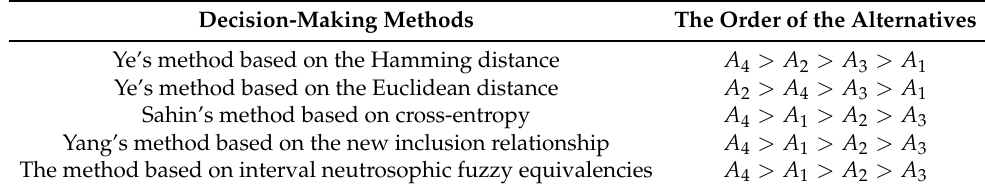
Table 4. The comparison of results of the decision-making methods in Example